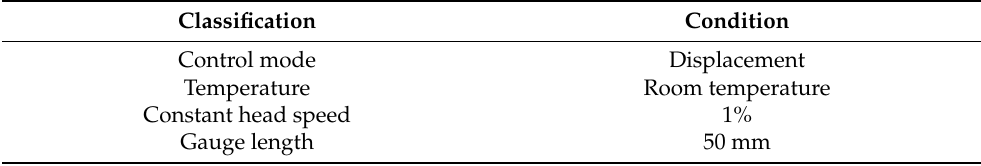
Table 2. Tensile test conditions. Classification Condition Control mode Displacement